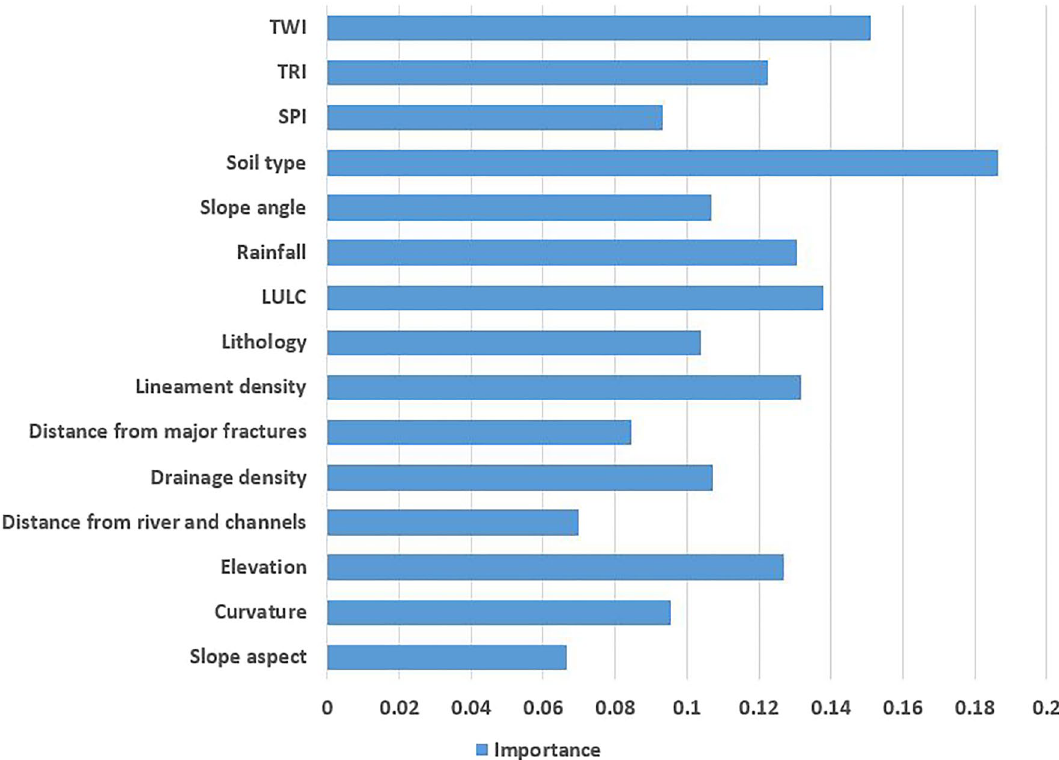
Fig. 10 Effective features importance for GWPM prediction using the RF classification